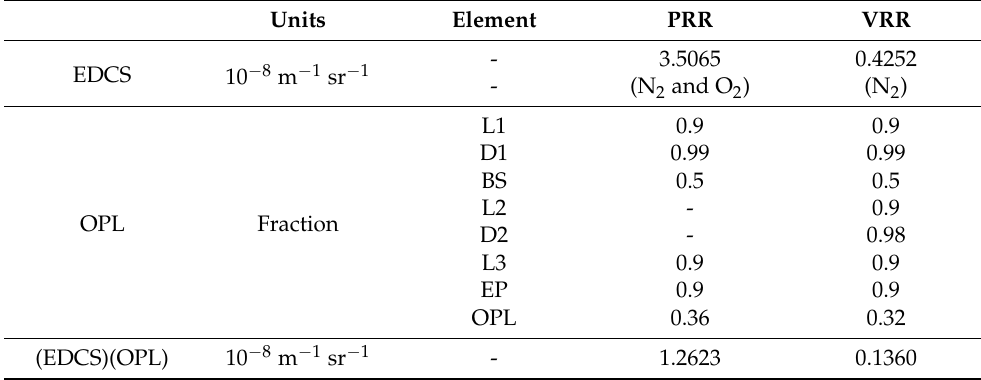
Table 3. Calculated Effective Differential Cross-Sections (EDCS) and Optical Path Loss (OPL) of Pure rotational Raman (PRR) and Vibro-rotational Raman (VRR) lines/channels. The optical path loss is estimated for the entire optical path behind the fiber bundle excluding the interference filters. Units